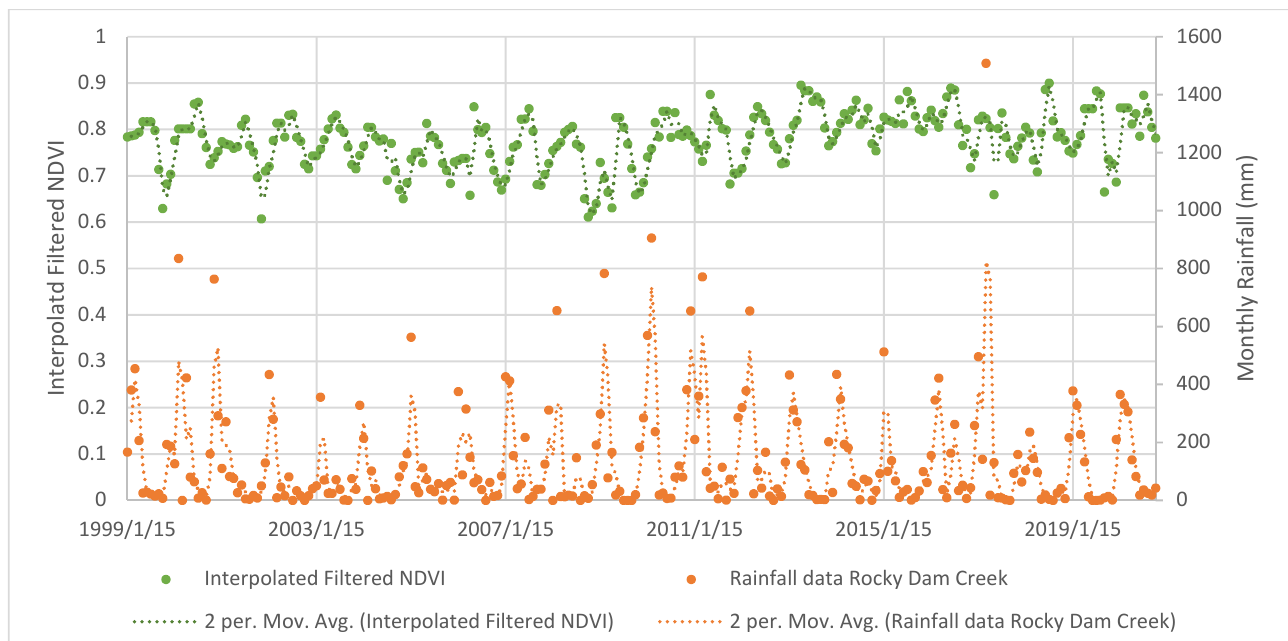
Figure 8. Interpolated, filtered NDVI and rainfall trendlines for the mid-section of our study region, Rocky Dam Creek/Cape Palmerston National Park, rainfall data gathered from Koumala Station (station number: 33038).